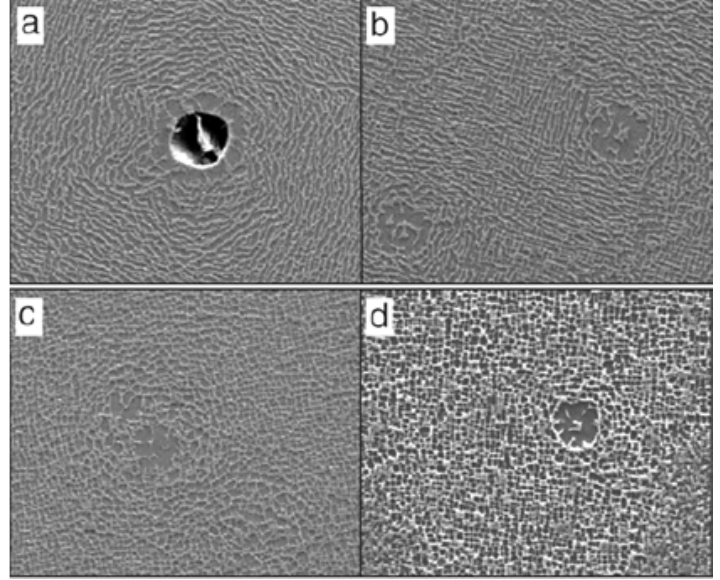
Figure 6. Pores closure in SX superalloy ERBO/1 after HIP at different conditions. ( a , b ) 200 MPa, 5 h, 1200 °C, and 10 K/min cooling rate; ( c ) 200 MPa, 5 h, 1300 °C, and 10 K/min cooling rate; ( d ) 100 MPa, 3 h, 1300 °C, and 20 K/min cooling rate [24] .